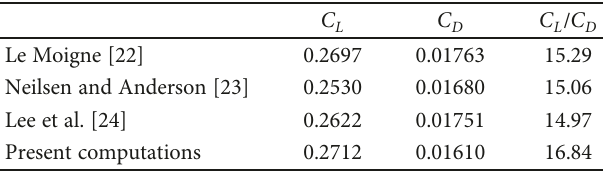
Figure 18: Pressure distribution on the ONERA M6 wing at station η = 0 2 , 0.44, and 0.99. Table 3: Lift and drag coe ffi cients on the ONERA M6 plain